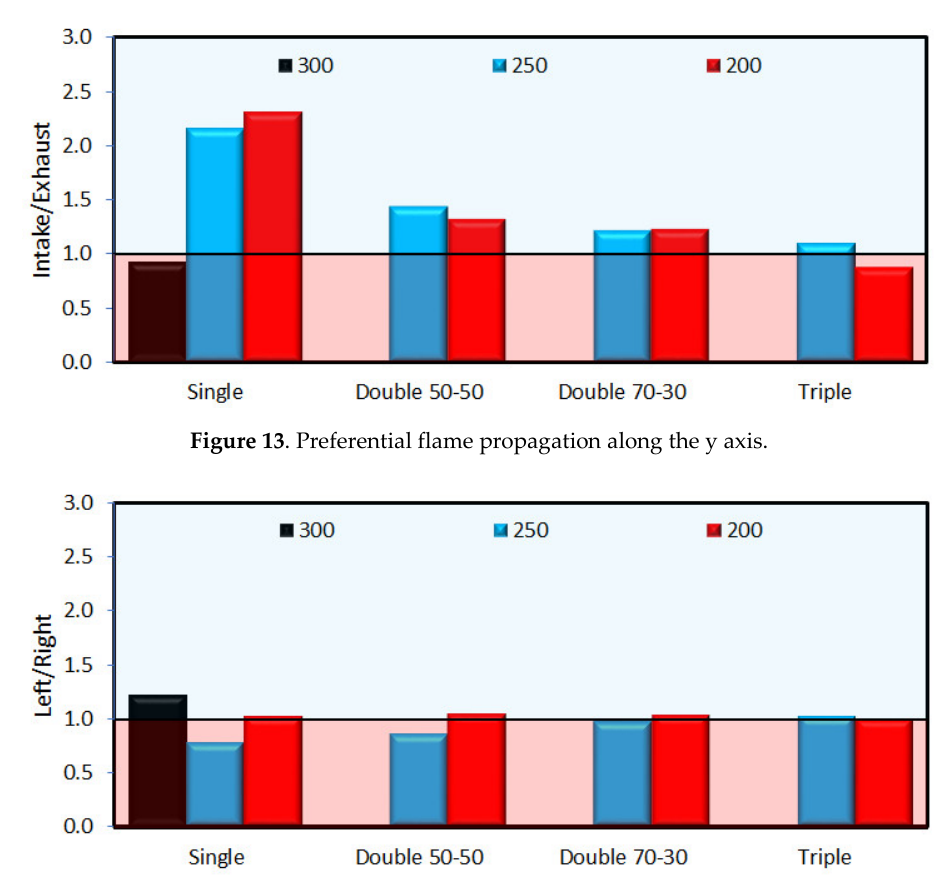
Figure 14 . Preferential flame propagation along the x